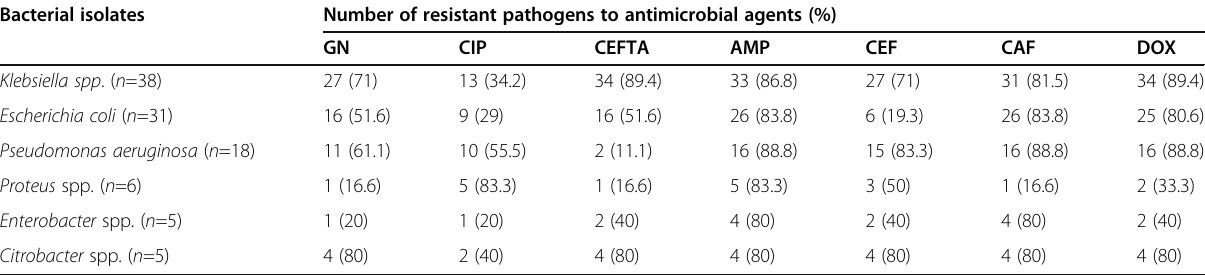
Table 5 Antimicrobial susceptibility patterns of gram-negative bacterial isolates from wound swab cultures of postoperative surgical site infections Bacterial isolates Number of resistant pathogens to antimicrobial agents (%) GN CIP Klebsiella spp . ( n